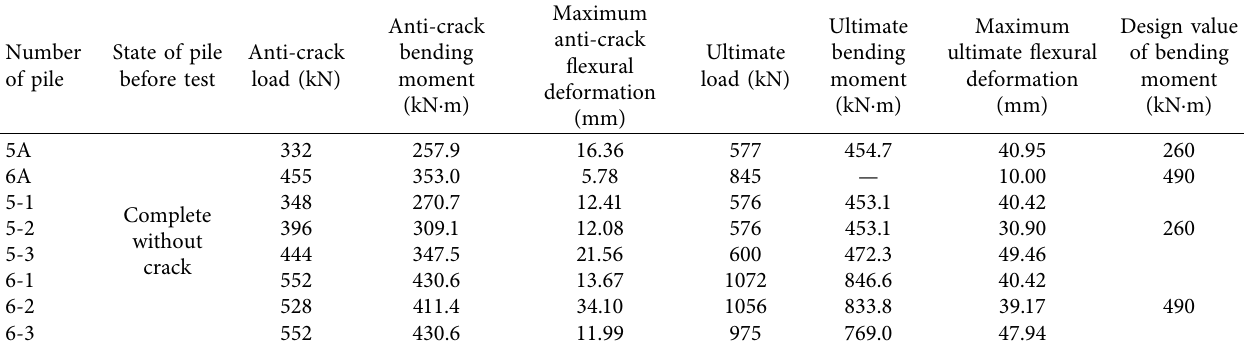
Table 3: Anti-crack load, ultimate load, bending moment, and fexural deformation.